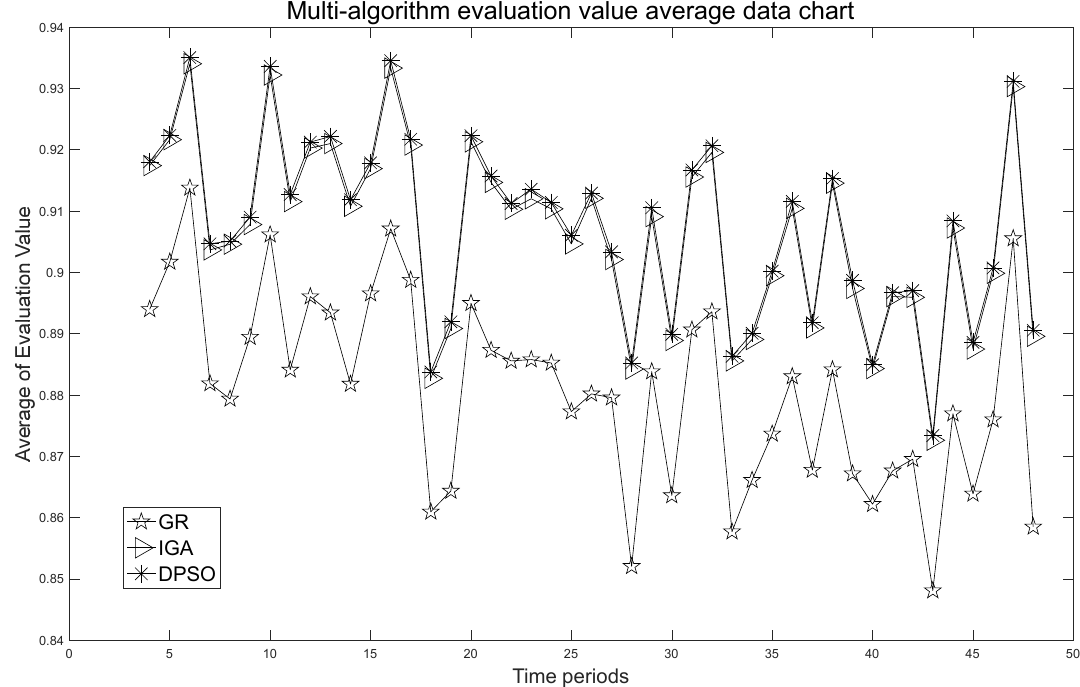
Figure 4. Multi-algorithm evaluation value comparison chart.